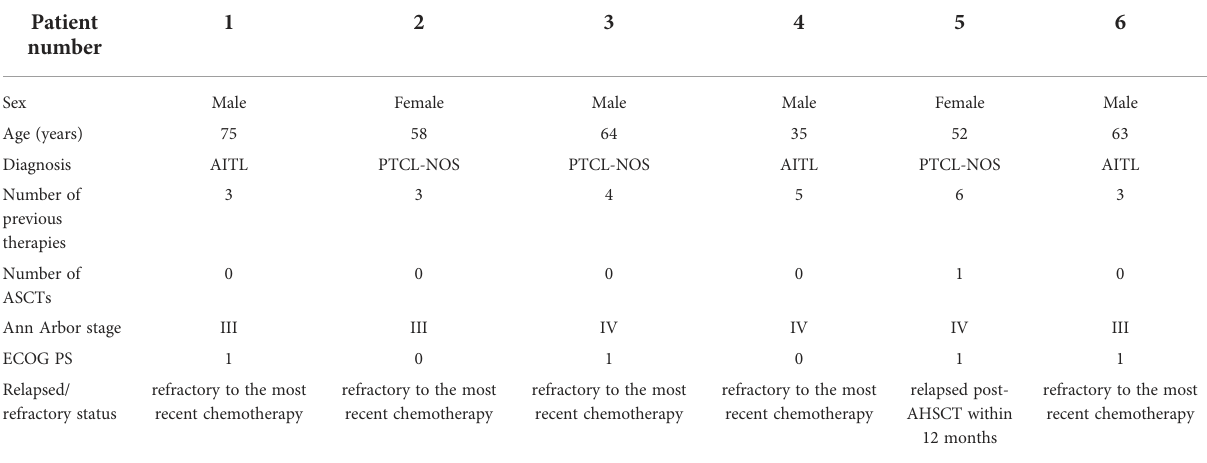
TABLE 1 Baseline characteristics of